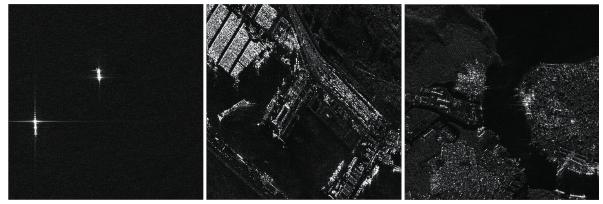
Figure 9. Some samples from HRSID